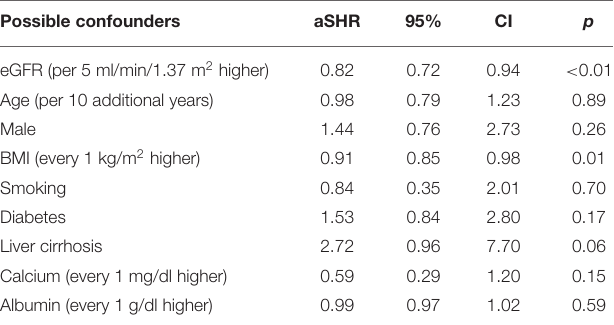
TABLE 4 | Adjusted subdistribution hazard ratios (aSHRs) of possible confounders for tuberculosis in multivariate competing-risks analysis. Possible confounders